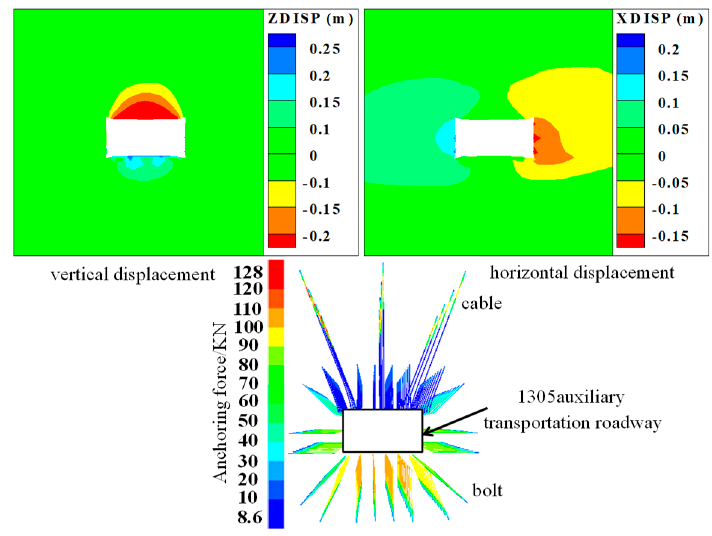
Figure 8. The numerical simulation result of the new support design.